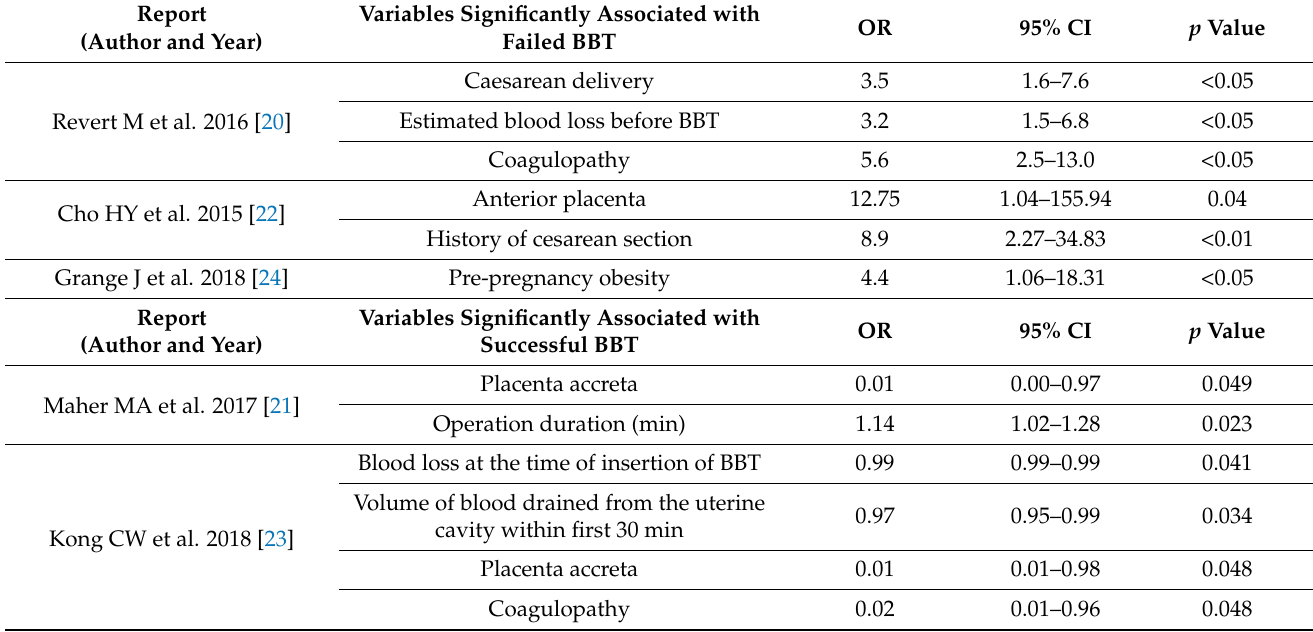
Table 4. Logistic regression analysis of studies reported in the systematic